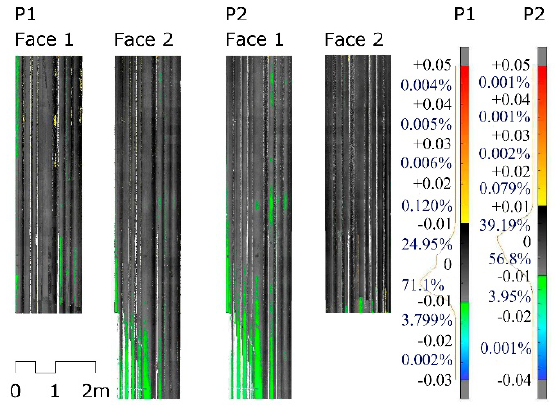
Figure 11: Deployment of the flatness study of the pillars.